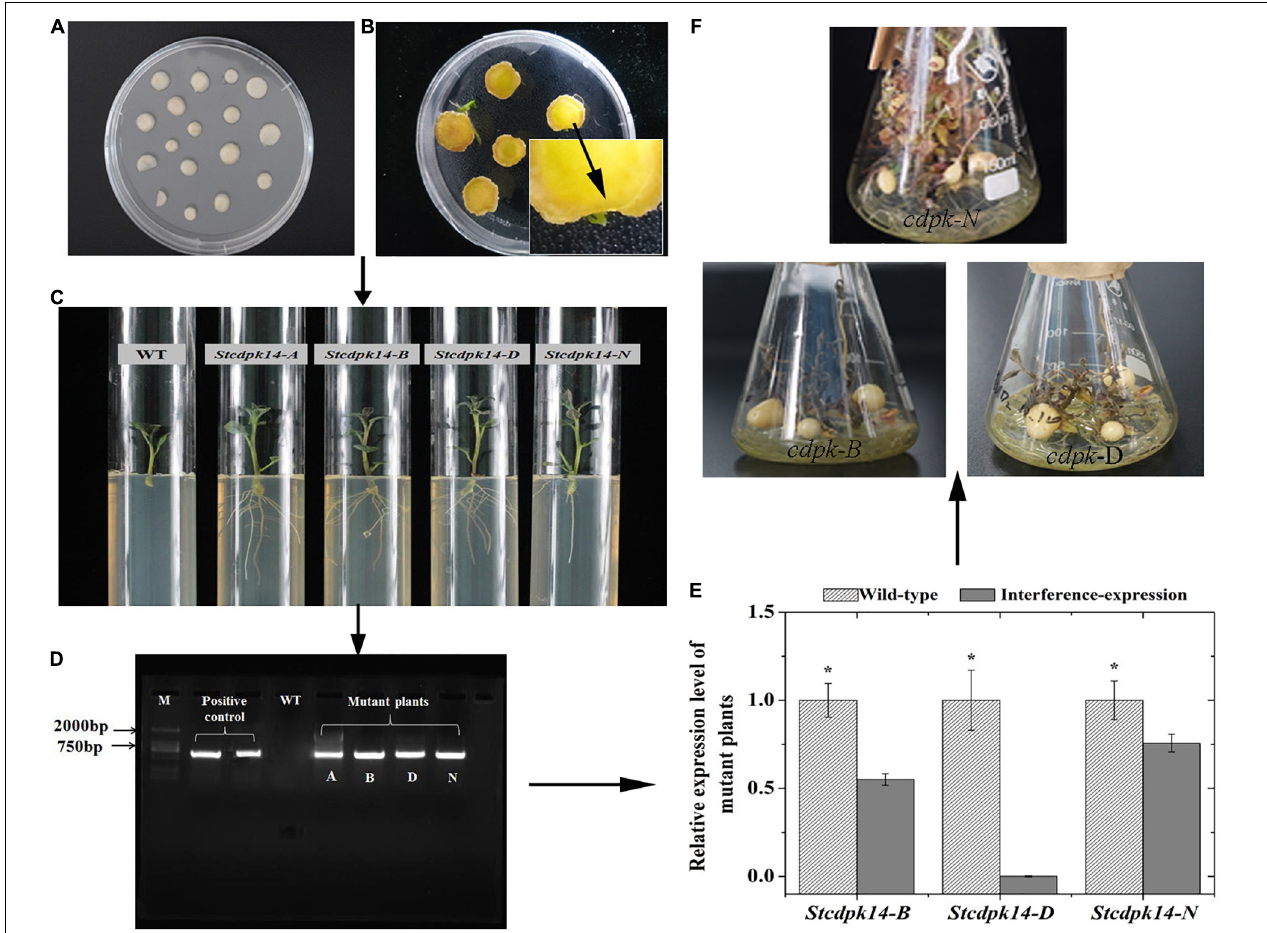
FIGURE 5 | Regeneration and verification of StCDPK14 transgenic potato tubers. ( A : Callus formation on the center of tuber slices; B : Shoot formation; C : The roots selection of transgenic plant; D : PCR identification of genomic DNA from Kana-resistant potato plant (M: DL2000 marker); E : Quantitative RT-PCR analysis of StCDPK14 in the transgenic tubers; F : Growth of transgenic tuber). Asterisk indicates a significant difference ( P < 0.05) between wild-type and interference-expression